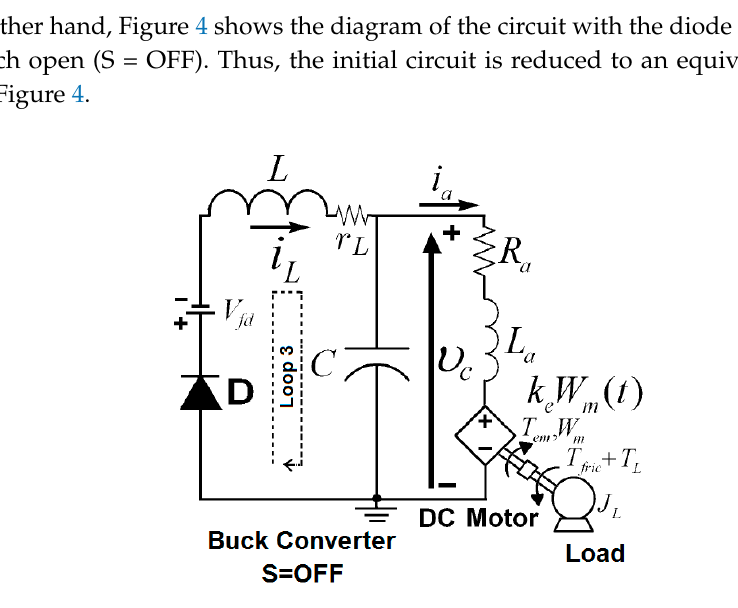
Figure 4. Electromechanical system with the switch OFF.